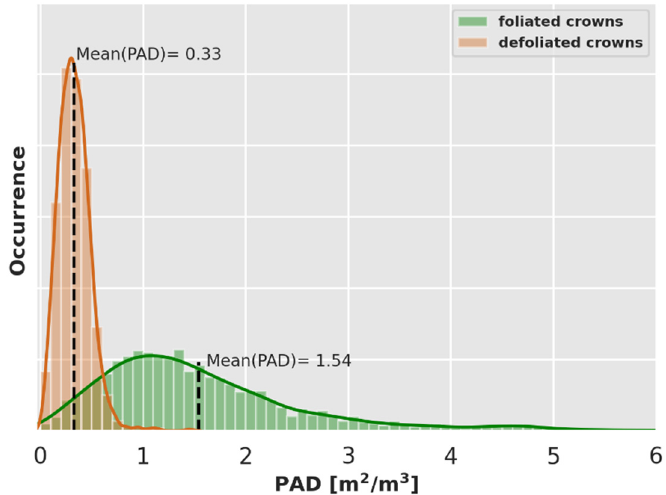
Figure 4. Distribution of mean plant area density (PAD) of the three uppermost voxels corresponding to foliated and defoliated tree crowns delineated from VHSR data interpretation.